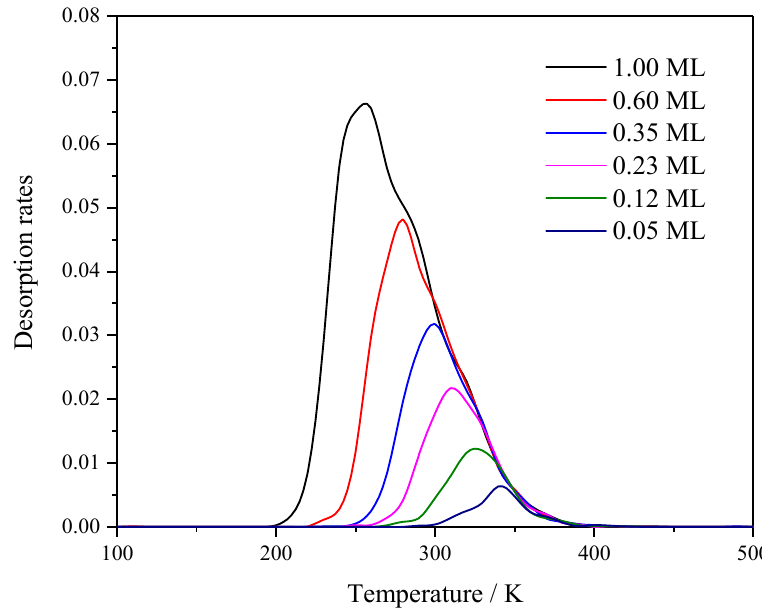
Figure 9. H 2 TDS spectra calculated by kMC simulation based on DFT calculation.